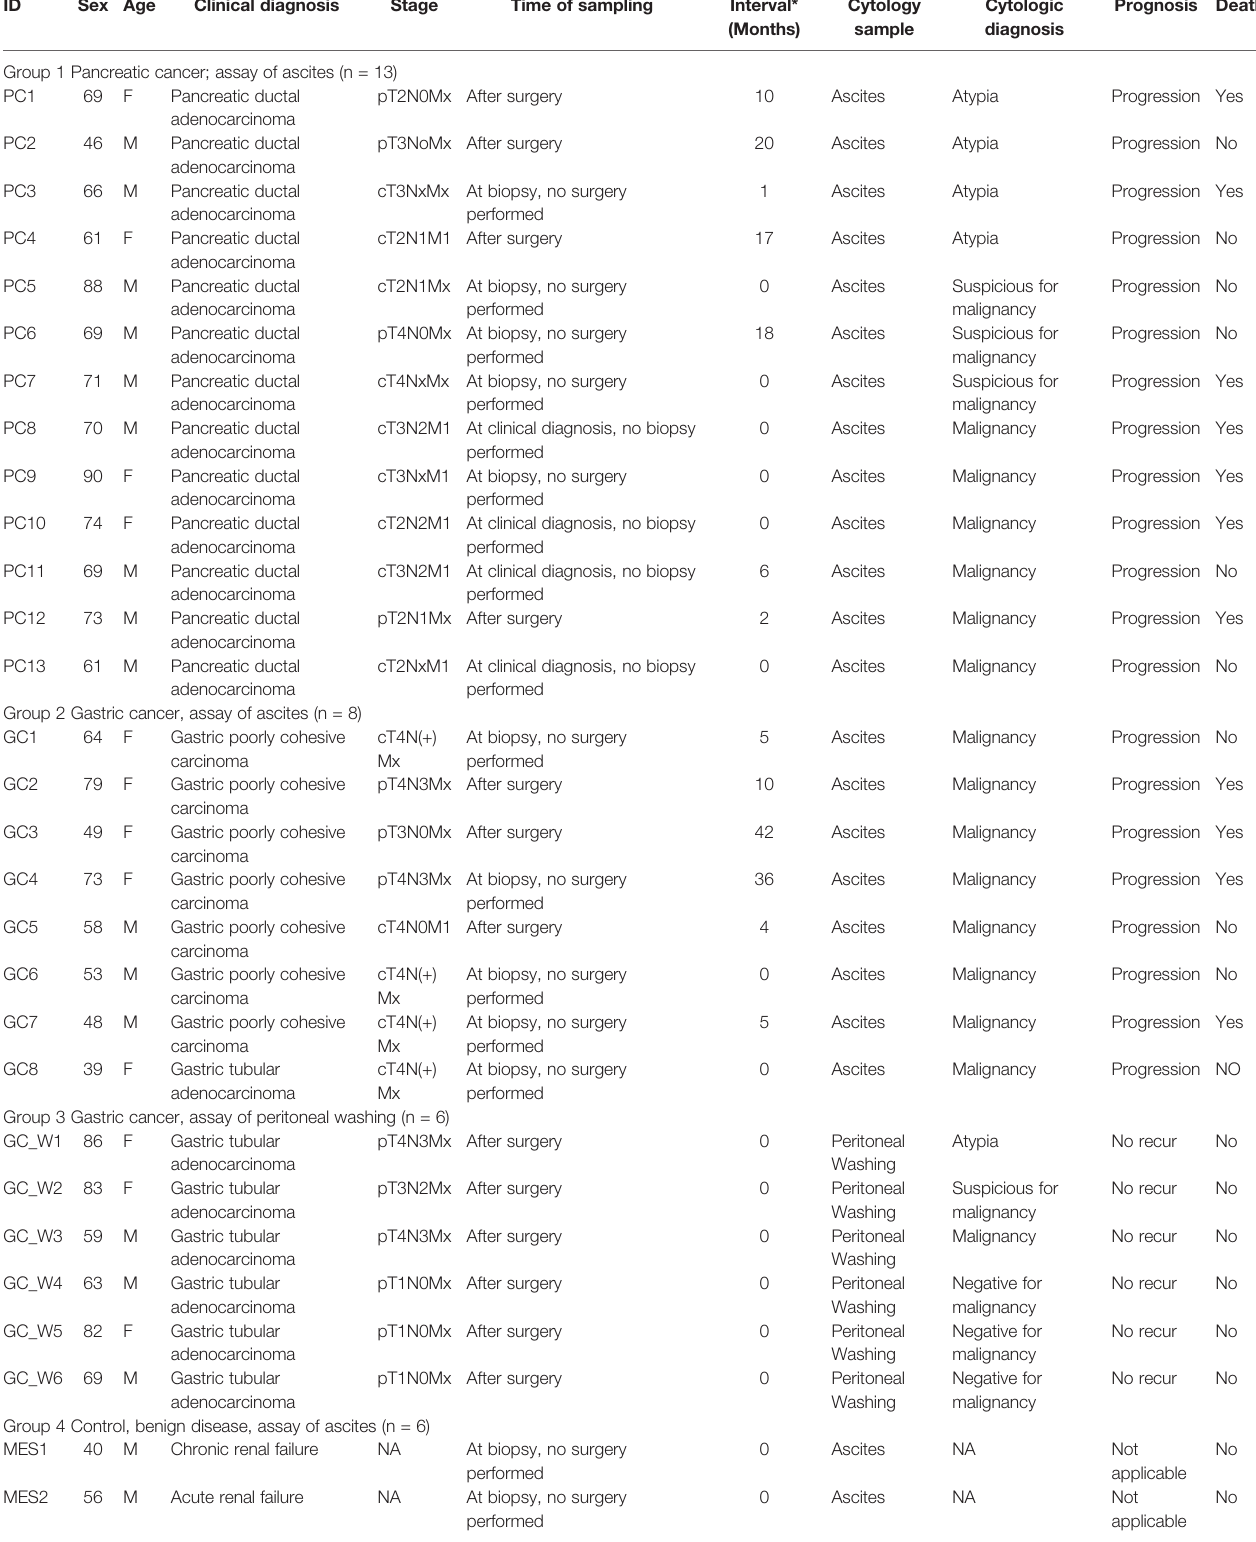
TABLE 2 | Detailed description of the patients (n =